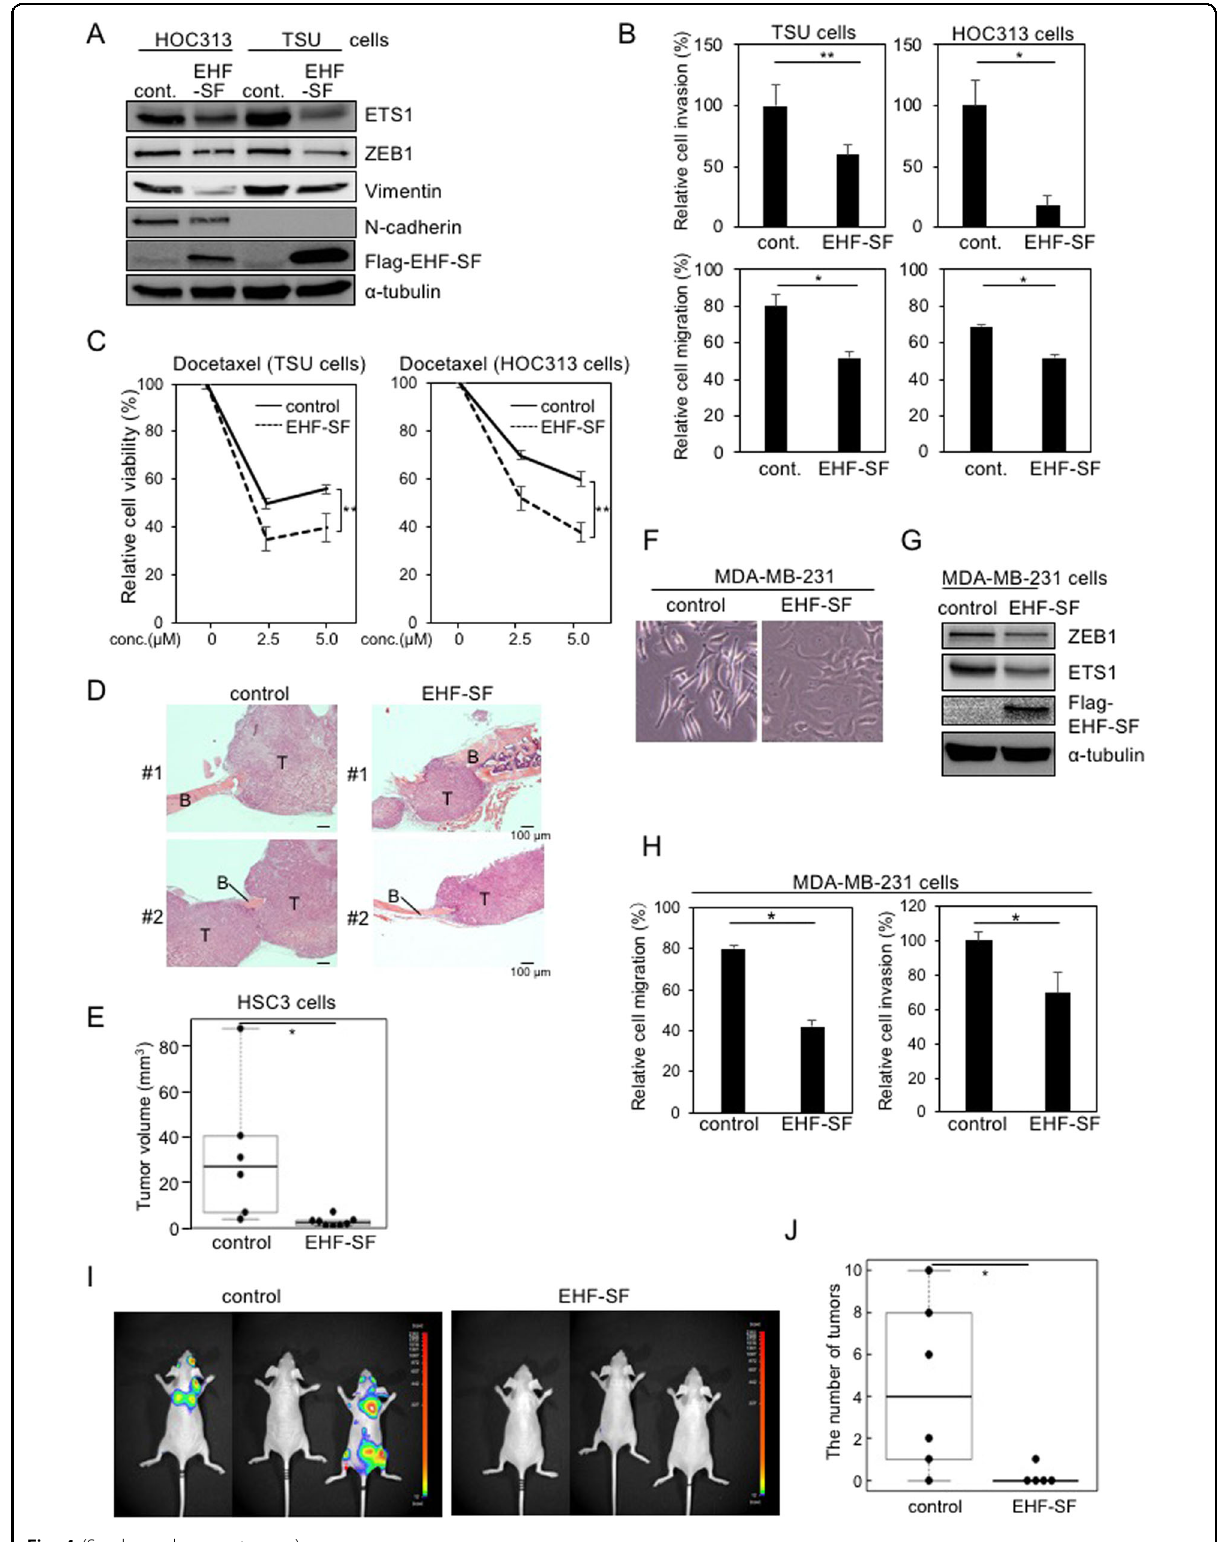
Fig. 4 (See legend on next